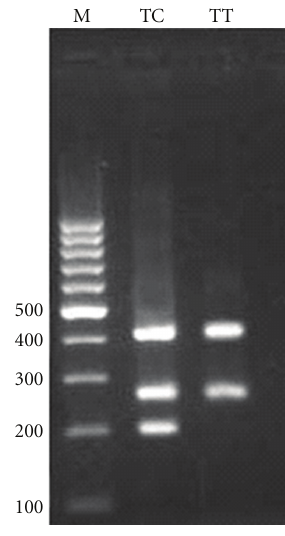
Figure 2: Electrophoresis pattern of tetra-amplification refractory mutation system-polymerase chain reaction (T-ARMS-PCR) for detection of SNP in IRGM − 1161 C/T. M : DNA marker. Product sizes were 199 bp for C allele, 261 bp for T allele, and 415bp for control